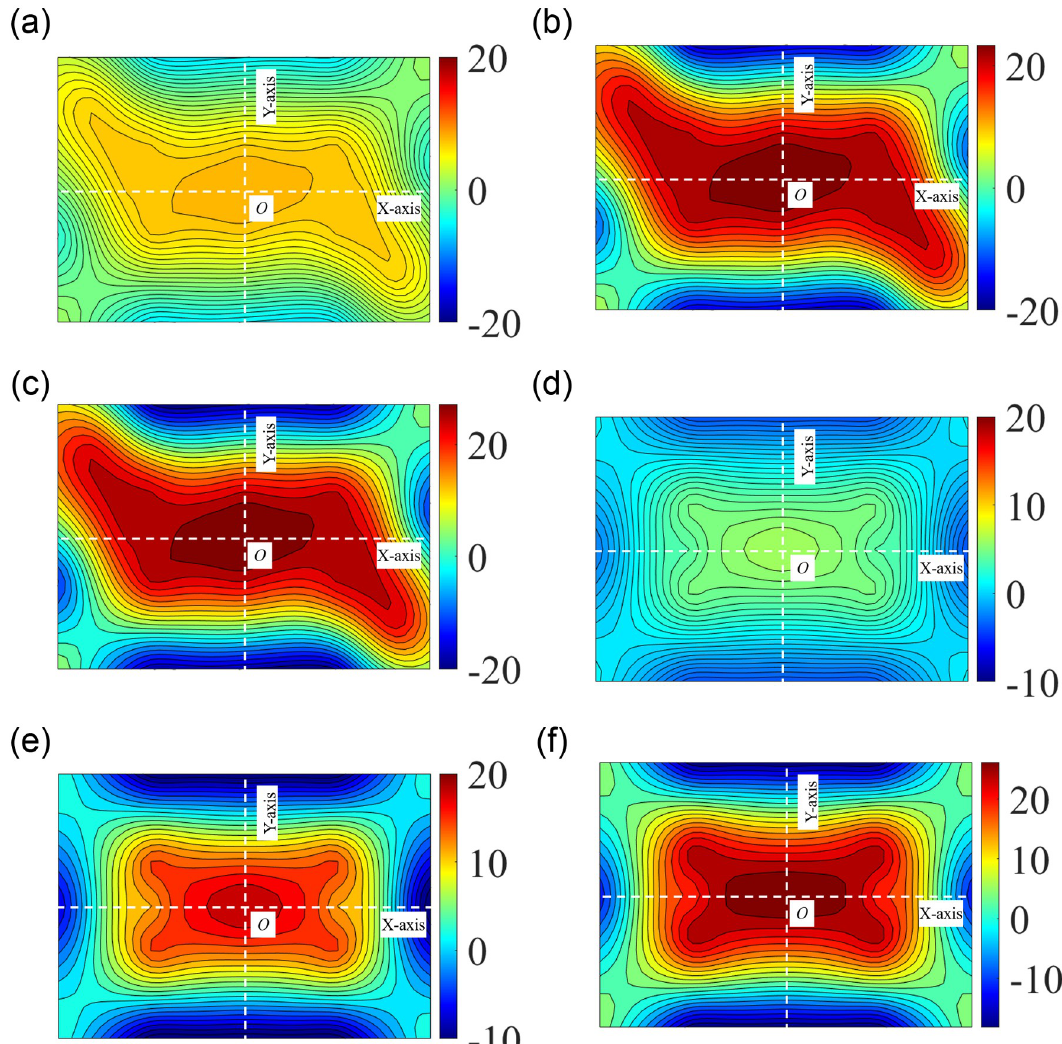
Fig 7. Stress nephograms in uniform load test on surface U-2 [MPa]. (a) SJ2,1kPa; (b) SJ2,3kPa; (c) SJ2,5kPa; (d) SJ1,1kPa; (e) SJ1,3kPa; (f)